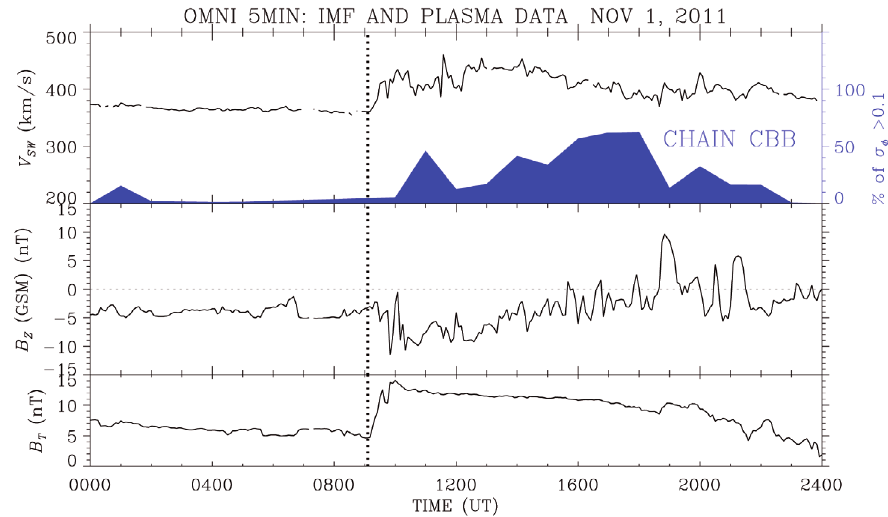
Figure 6. Solar wind magnetic field and plasma parameters from OMNIWeb dataset combining available solar wind monitor data projected to the nose of the Earth bow shock. The hourly percent occurrence of v U > 0.1 rad from Cambridge Bay is highlighted in blue.